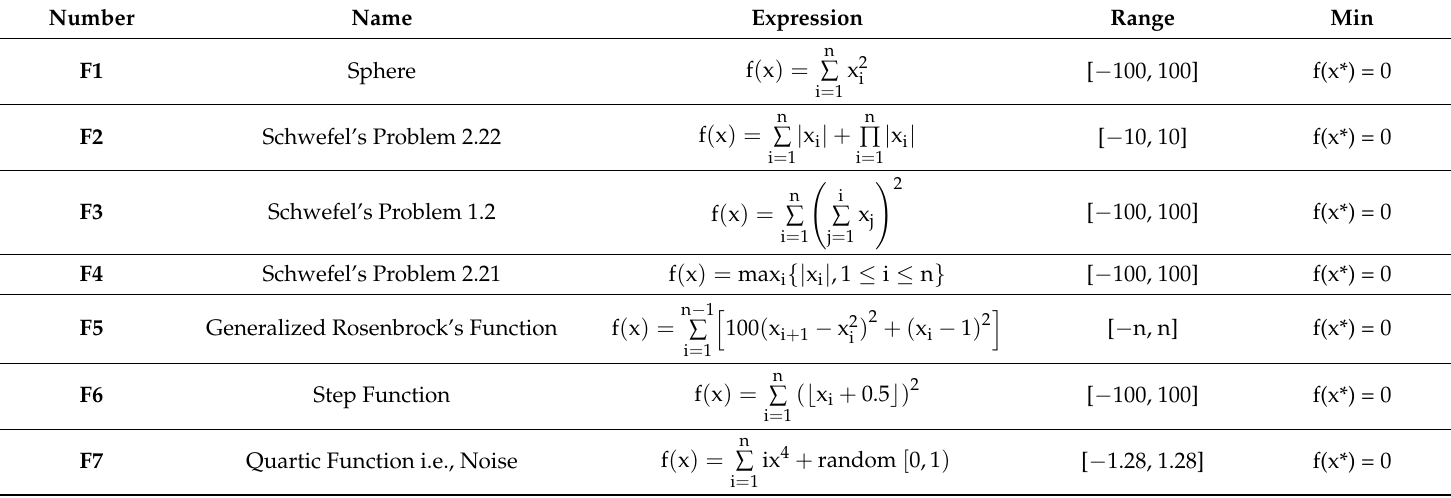
Table 2. Unimodal test functions considered for